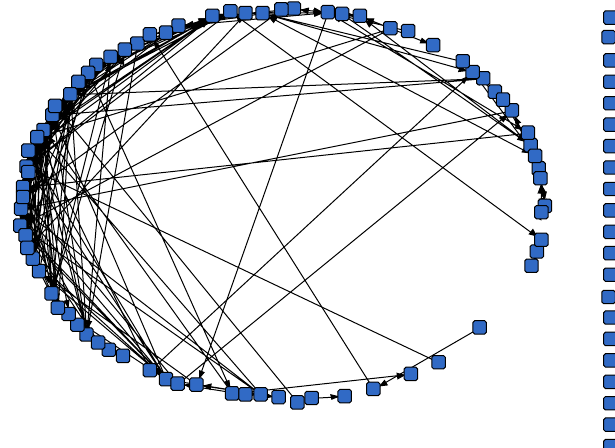
FIG. 2 (color online). Sociogram of all 99 students responding to the PLC survey. Each student is represented as a blue square and arrows represent ties between students. The line of 23 blue squares on the right-hand side of the diagram are students that had no tie to any other student in the network.